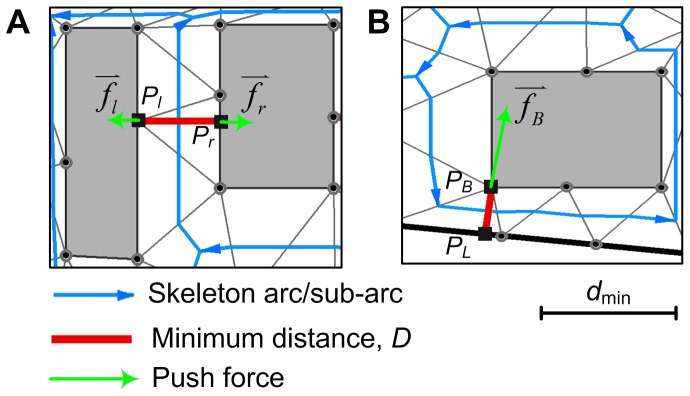
Detection of proximity conflict and calculation of push force.(A) BB-conflict and (B) BL-conflict.